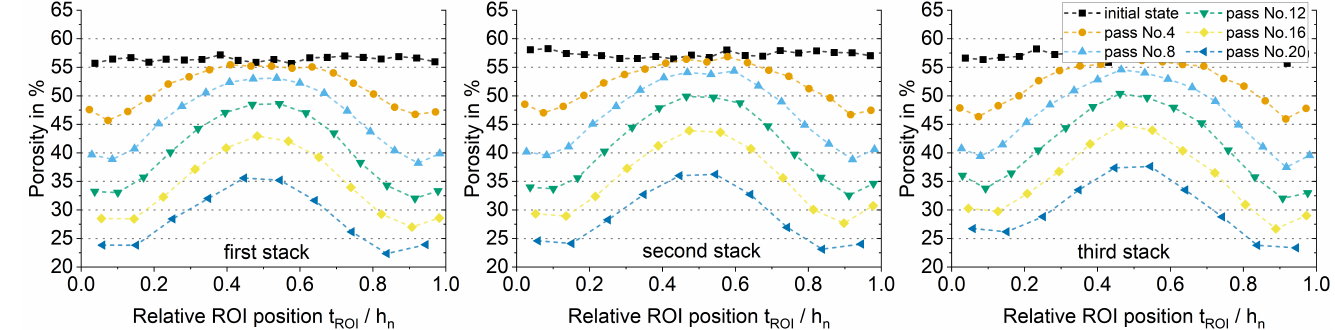
Figure 8. Series I: 20-0.50-20 ( l d / h m ≈ 0.5): Porosity change over relative sample depth (0=upper surface; 0.5= mid-section of sample; 1=lower surface) due to rolling for first, second and third